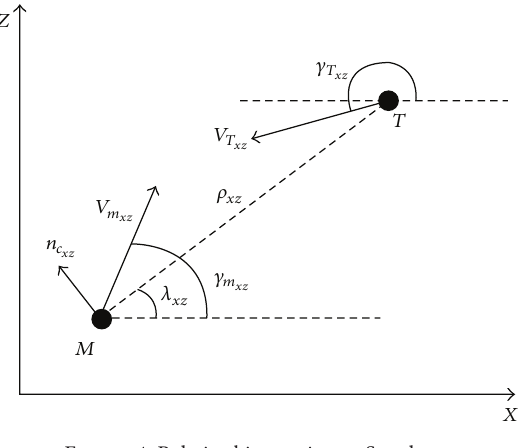
Figure 4: Relative kinematics on 𝑆 𝑥𝑧 plane.